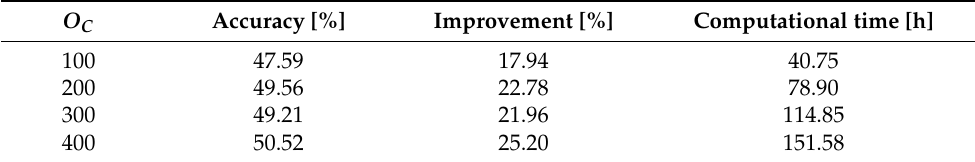
Table 8. Optimization experimentally obtained results for O C